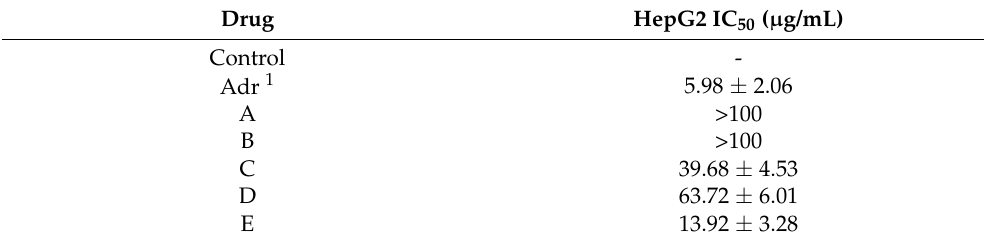
Table 1. Cell viabilities of HepG2 cells treated by fractions A–E.